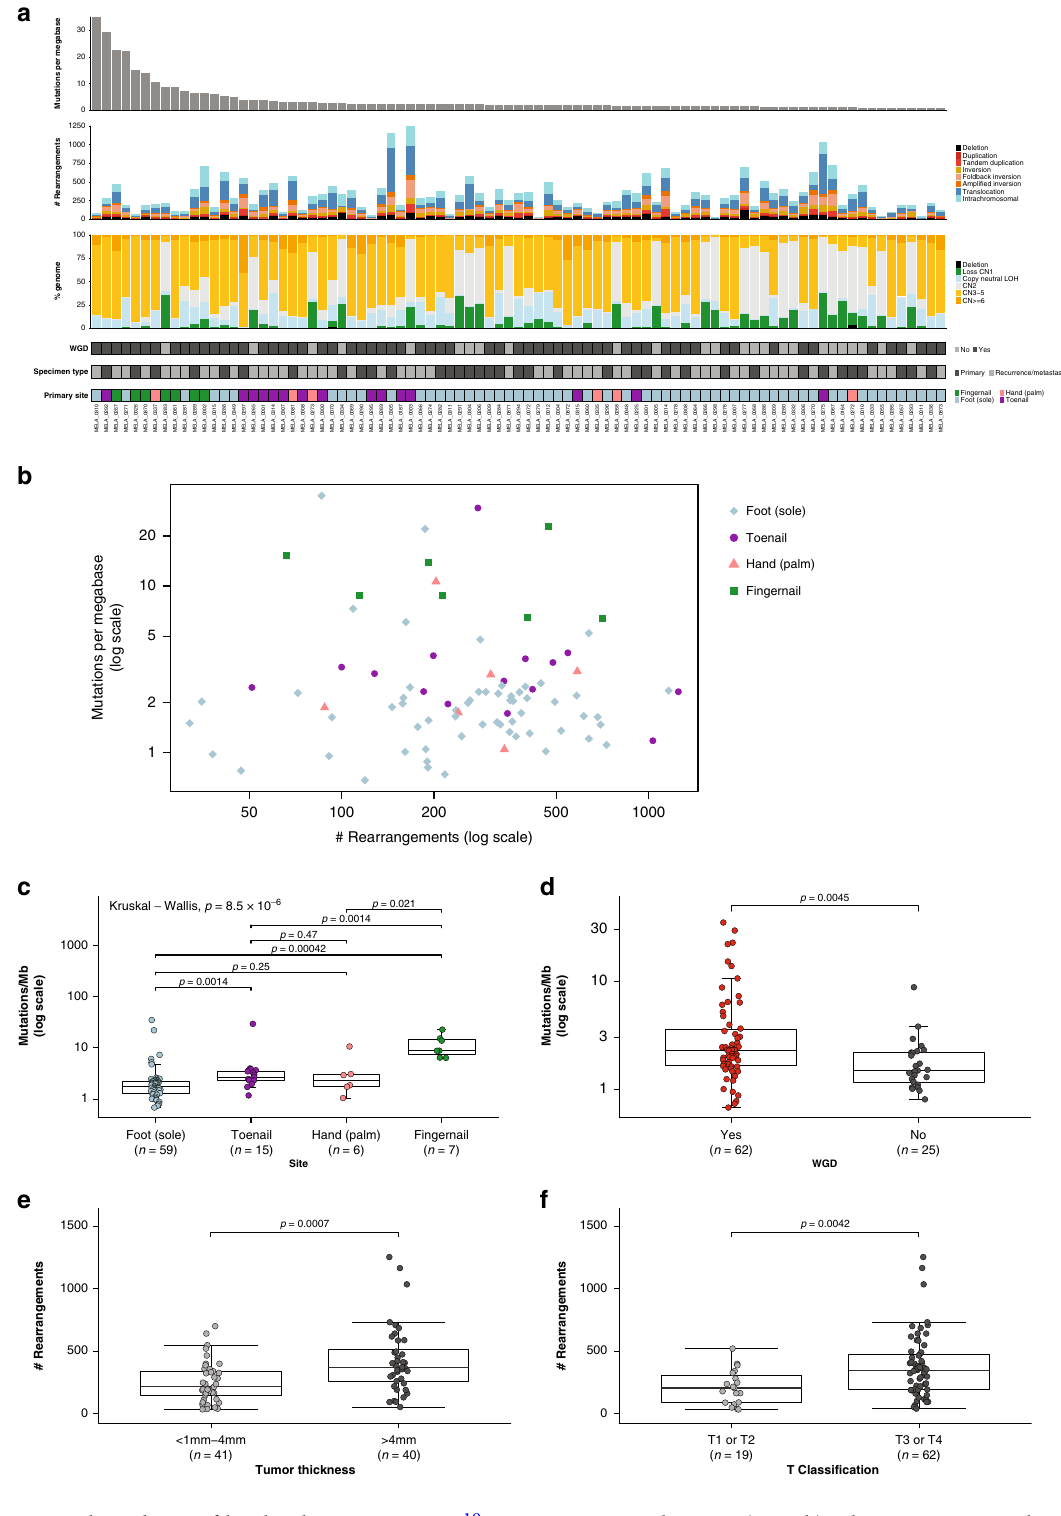
CNS7 (Fig. 3a, Supplementary Fig. 2c,